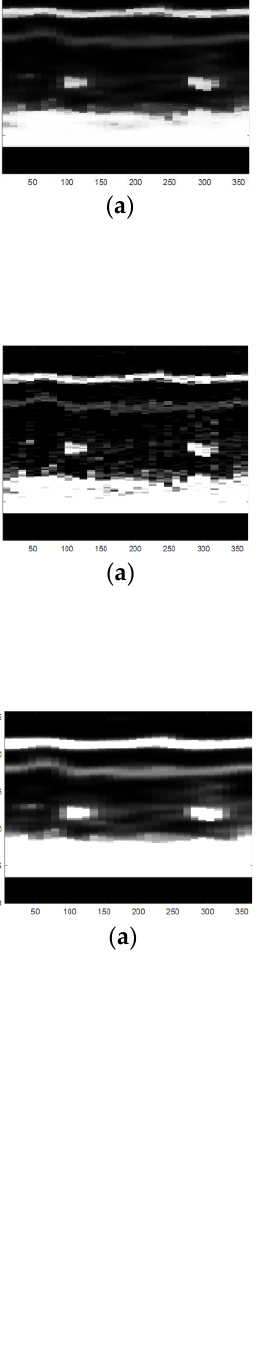
( d ) Figure 14. The defect images processed by the three-threshold maximum inter-class variance method: ( a ) small crack, ( b ) transverse crack, ( c ) hole defect, and ( d ) chapped defect.